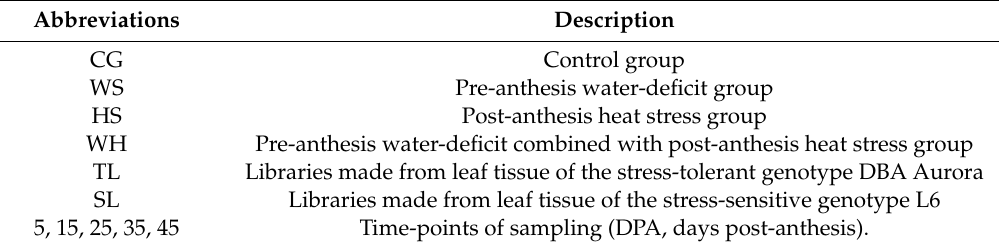
Table 1. Summary of abbreviations used for next-generation library